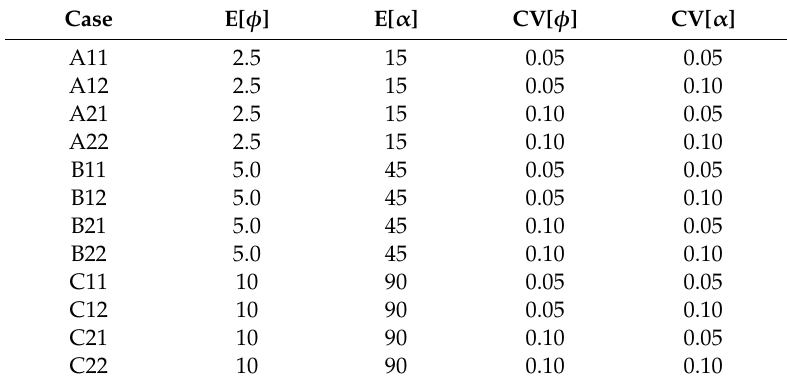
Table 2. Combinations of prior values with respect to mean value and coe ffi cient of variation (CV) of the input random variable (RV) ( φ , α